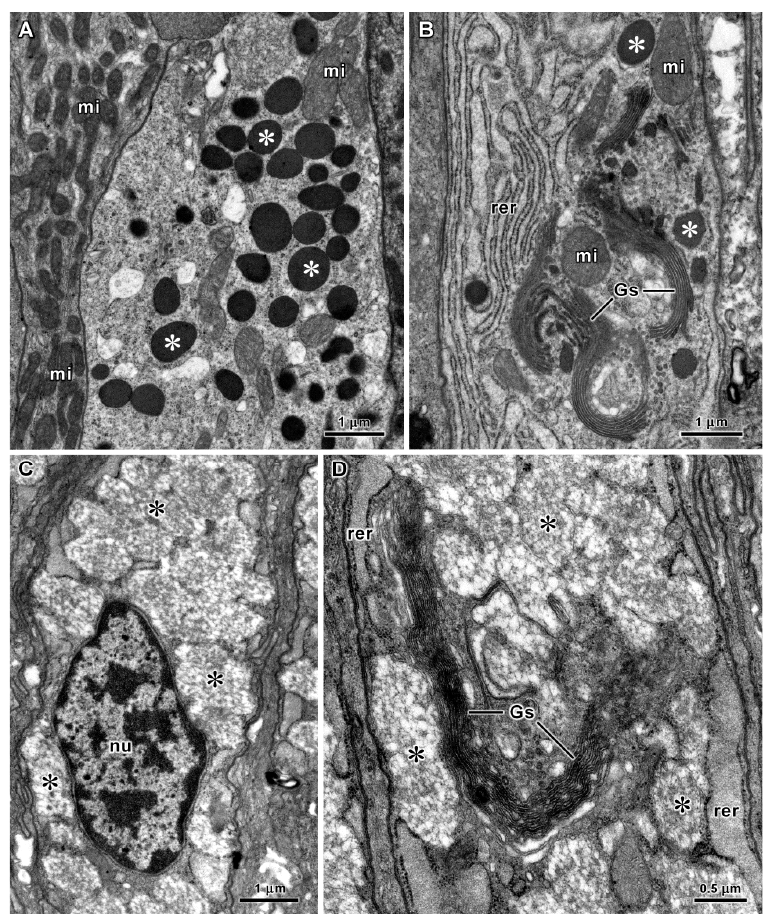
Figure 13. Ultrastructure of intestinal secretory cells in C. angulata ( A , B ) and A. fascicularis ( C , D ). ( A , B ) Electron-dense vesicles (asterisks), rough endoplasmic reticulum cisternae (rer) and Golgi stacks (Gs) in basophilic secretory cells of the anterior intestine. ( C , D ) Mucous cells of the valve between the anterior and posterior intestine in A. fascicularis with partially fused secretory vesicles (asterisks). These cells contain dilated rough endoplasmic reticulum cisternae (rer) and long Golgi stacks (Gs). nu—nucleus.